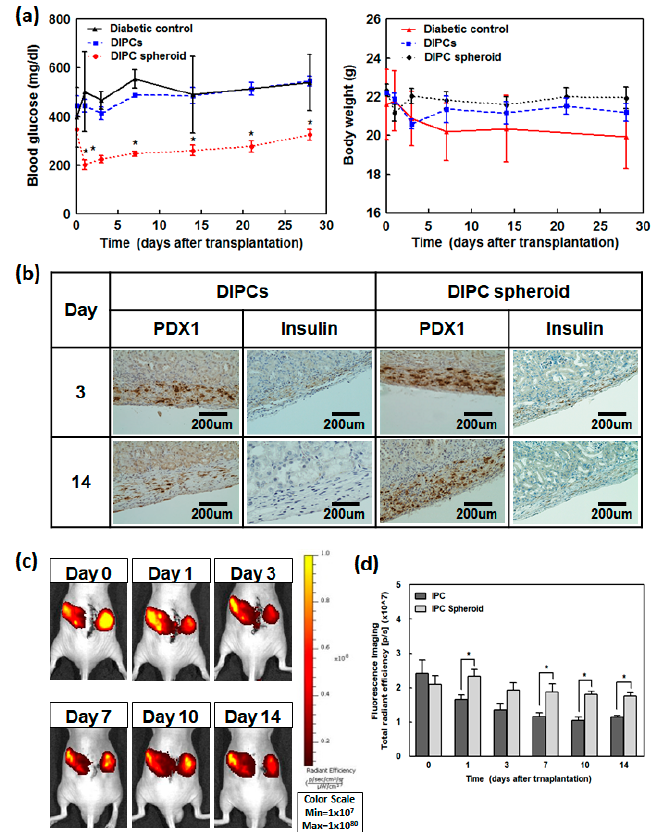
Figure 3. Therapeutic effects of DIPCs and DIPC spheroid transplantation in diabetic nude mice. Insulin-dependent diabetes was induced in mice using streptozotocin. On day 0, mice were transplanted with DIPCs or DIPC spheroids in the kidney capsule. Untreated diabetic mice were used as a negative control. ( A ) Non-fasting blood glucose levels and body weights were measured at different time points in diabetic control, DIPCs-, or DIPC spheroids-transplanted mice ( n = 4). The blood glucose level of the DIPC spheroids group decreased to 200 mg/dL after transplantation. Single-DIPC-transplanted mice revealed an increase in blood glucose for 4 weeks with no decrease. * indicates a significant reduction in blood glucose compared to DIPC; p < 0.05. ( B ) Immunohistochemical analyses of PDX1 and insulin in the liver 3 and 14 days after transplantation. Arrows indicate positive cell staining. Original magnifications: ×200 (PDX1); ×400 (insulin). Scale bars: 200 μ m (PDX1); 100 μ m (insulin). ( C ) Comparison of the transplantation efficiency between transplantation of DIPCs and spheroids in the subcutaneous site of mice. The images of transplanted DIPCs and spheroids were examined with an in vivo imaging system. DIPCs were optically imaged by labeling with Qdot 800 in vivo. ( D ) Quantification of the NIR signals of transplanted cells is expressed as total radiant efficiency (p/s) ( n = 4). * indicates a significant difference between two groups ( p < 0.05).